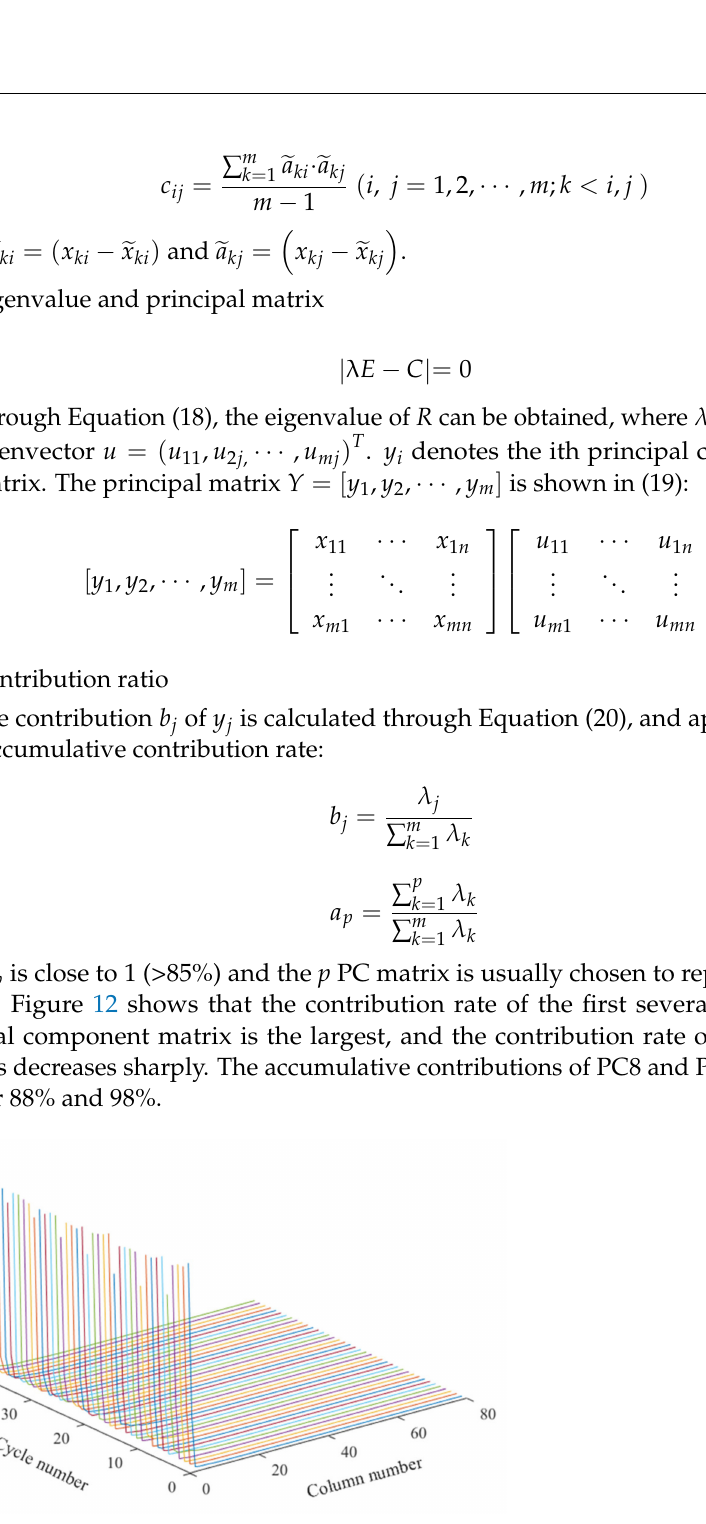
Figure 12. The contribution rate of PC